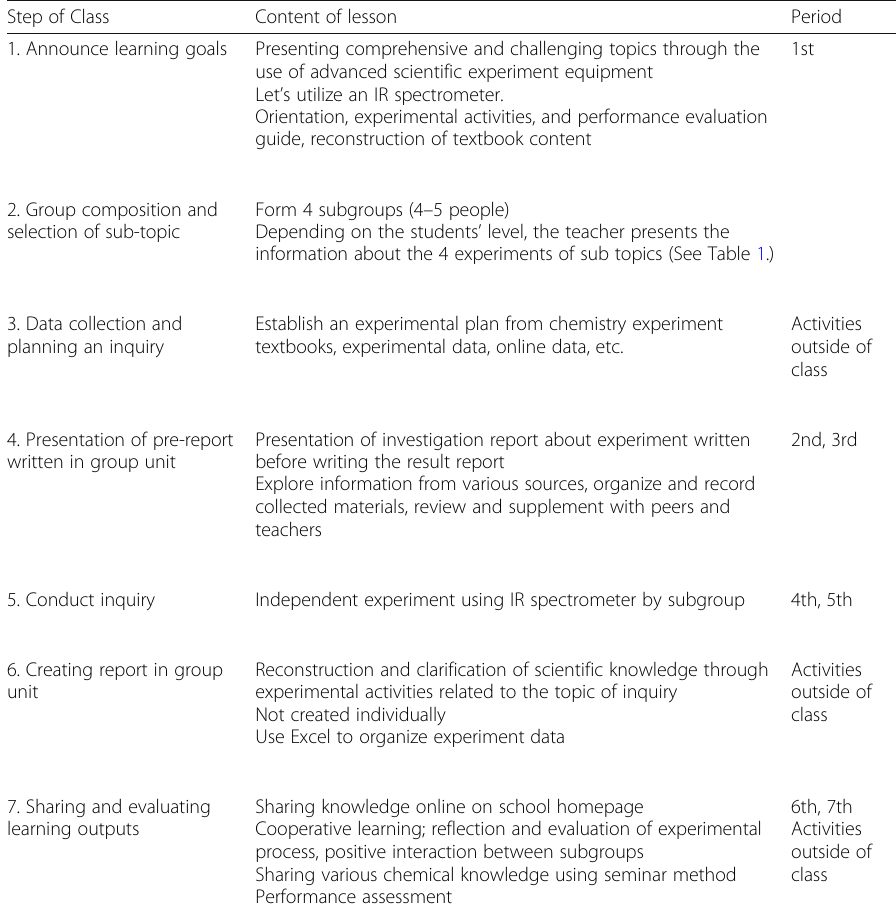
Table 6 Content of GI-ALE class (focused on IR spectrometer) Step of Class Content of lesson